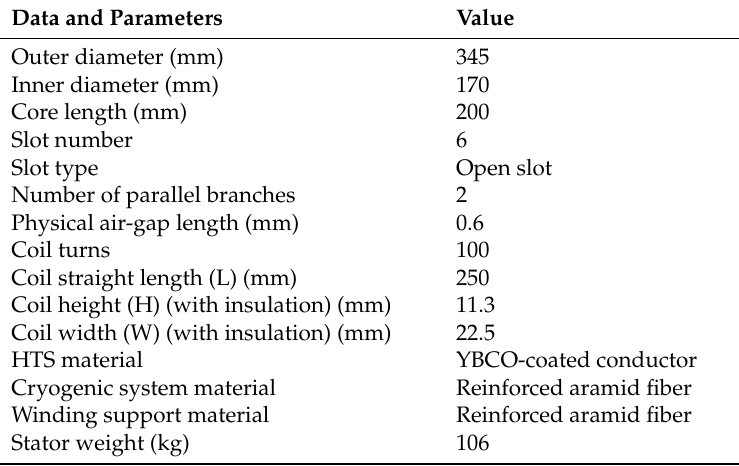
Table 3. Main design parameters of